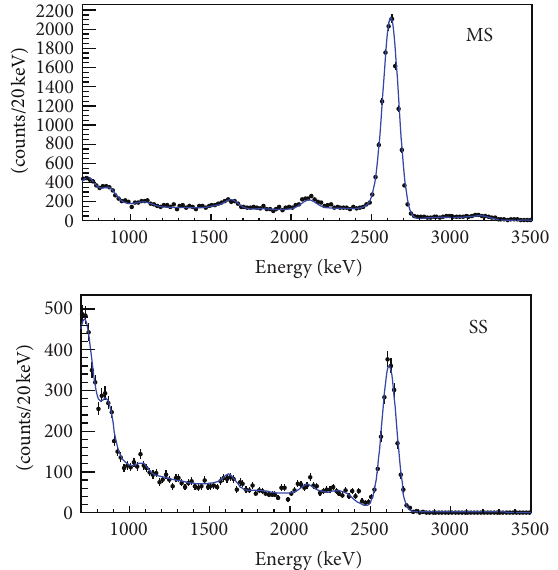
Figure 3: Multisite and single site data and Monte Carlo for a 228 Th source [25]. Excellent quantitative agreement is observed demonstrating that the detector is well